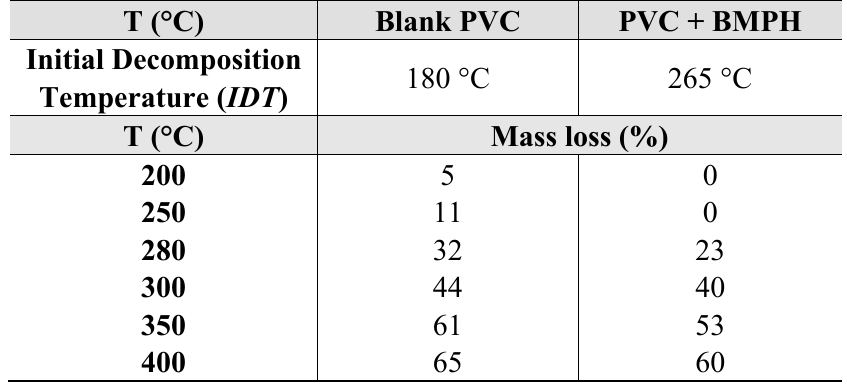
Table 4. Thermogravimetric data of blank PVC and PVC in presence of BMPH stabilizer. T